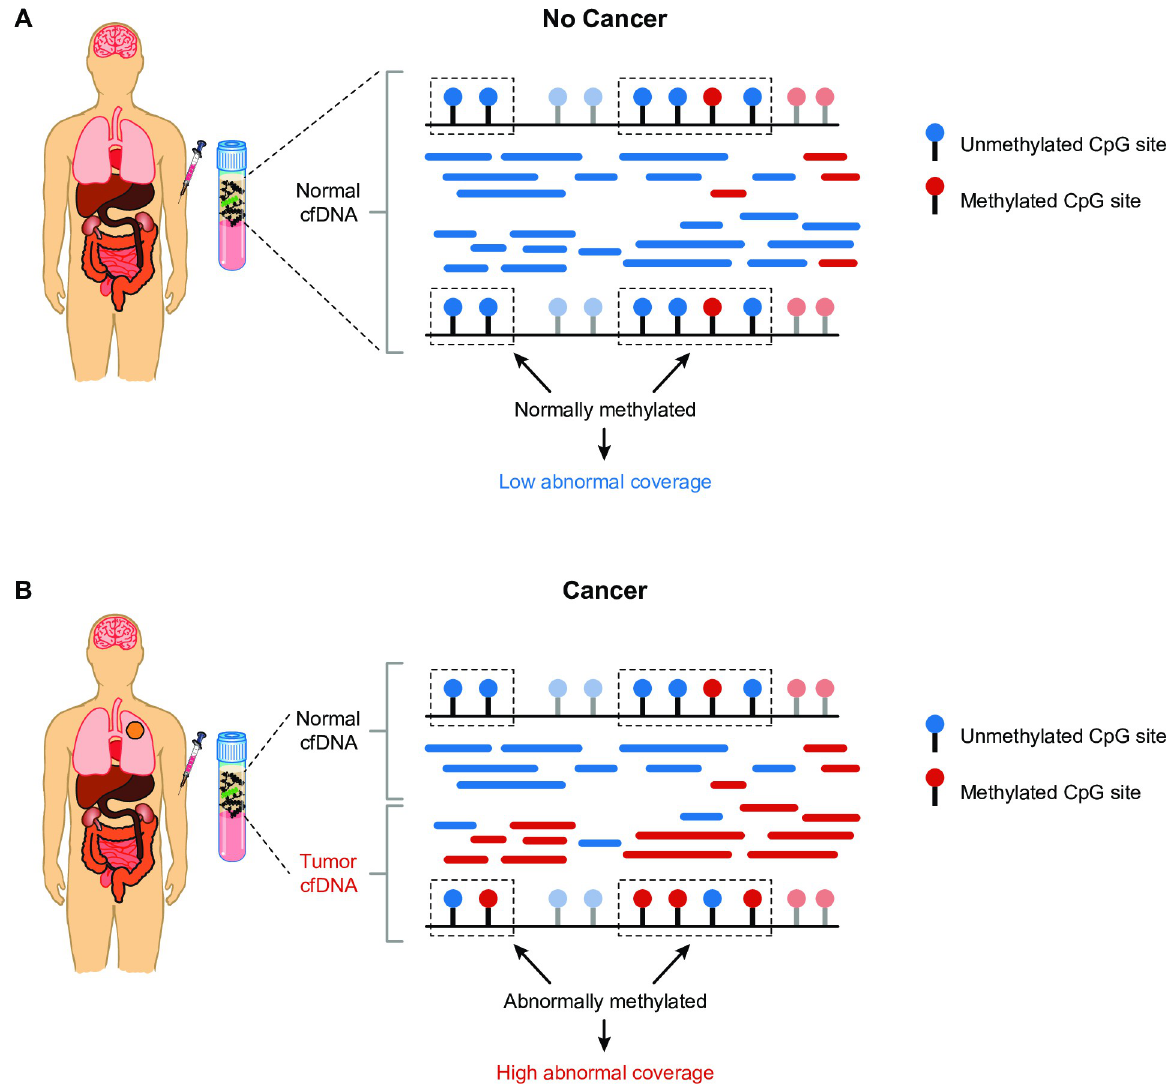
Fig 2. Abnormal coverage is a measure of abnormally methylated cell-free DNA (cfDNA) fragments analyzed by a targeted methylation- based multi-cancer early detection (MCED) test. In a healthy individual (A), plasma contains normal cfDNA shed by normal cells. In an individual with cancer (B; lung tumor represented by orange circle), plasma contains a mixture of normal and tumor cfDNA. Cell-free DNA fragments contain CpG methylation sites that may be either unmethylated (blue lollipops) or methylated (red lollipops), which are reflected in cfDNA sequencing reads (blue or red segments). In tumor cfDNA, some methylation regions are abnormally methylated (dotted rectangles in B), unlike cfDNA from individuals without cancer (A). The representation (coverage) of these abnormally methylated regions is quantified by abnormal coverage, which is a measure of cancer detection in the MCED test. The coverage of other regions that are not affected by cancer (light blue and light red lollipops) is quantified by binary target coverage, which is a measure of baseline test performance. cfDNA, circulating cell-free